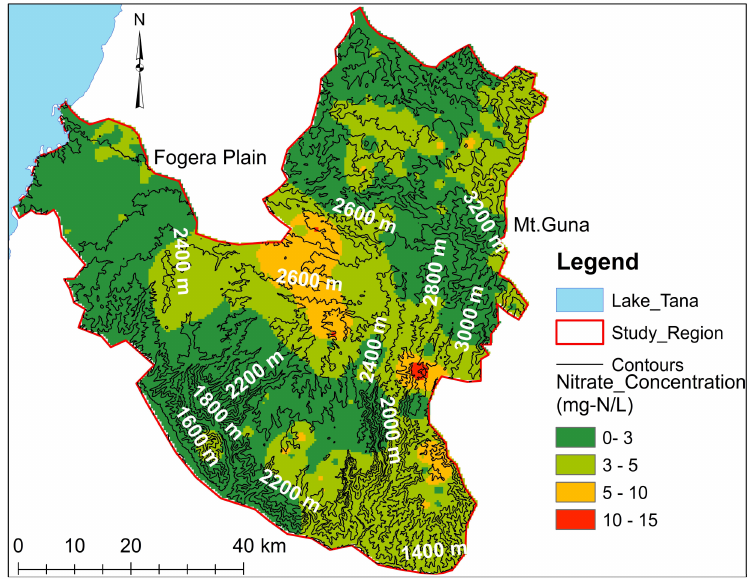
Figure 4. Topographic map (Black line denotes the elevation contours white color fonts denotes elevation contour) and the spatial distribution of nitrate concentrations in the study area in the Ethiopian highlands from wells and springs sampled from December 2013 to June